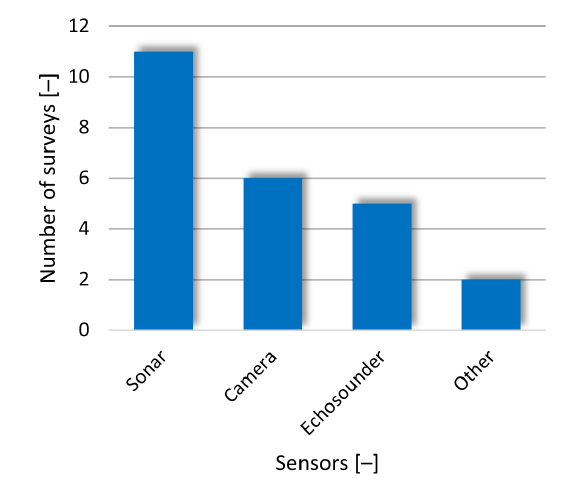
Figure 11. The number of surveys depending on the sensor used to perceive the environment. Due to the low attenuation level of acoustic signals in an underwater environment, sonar-based solutions are the most popular device chosen in